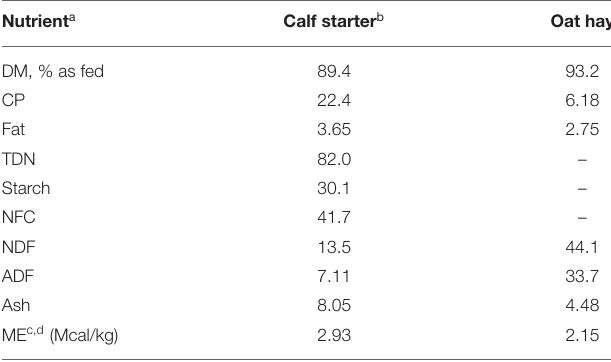
TABLE 2 | Chemical composition of calf starter (CS) and oat hay (OH) on a DM basis. Nutrient